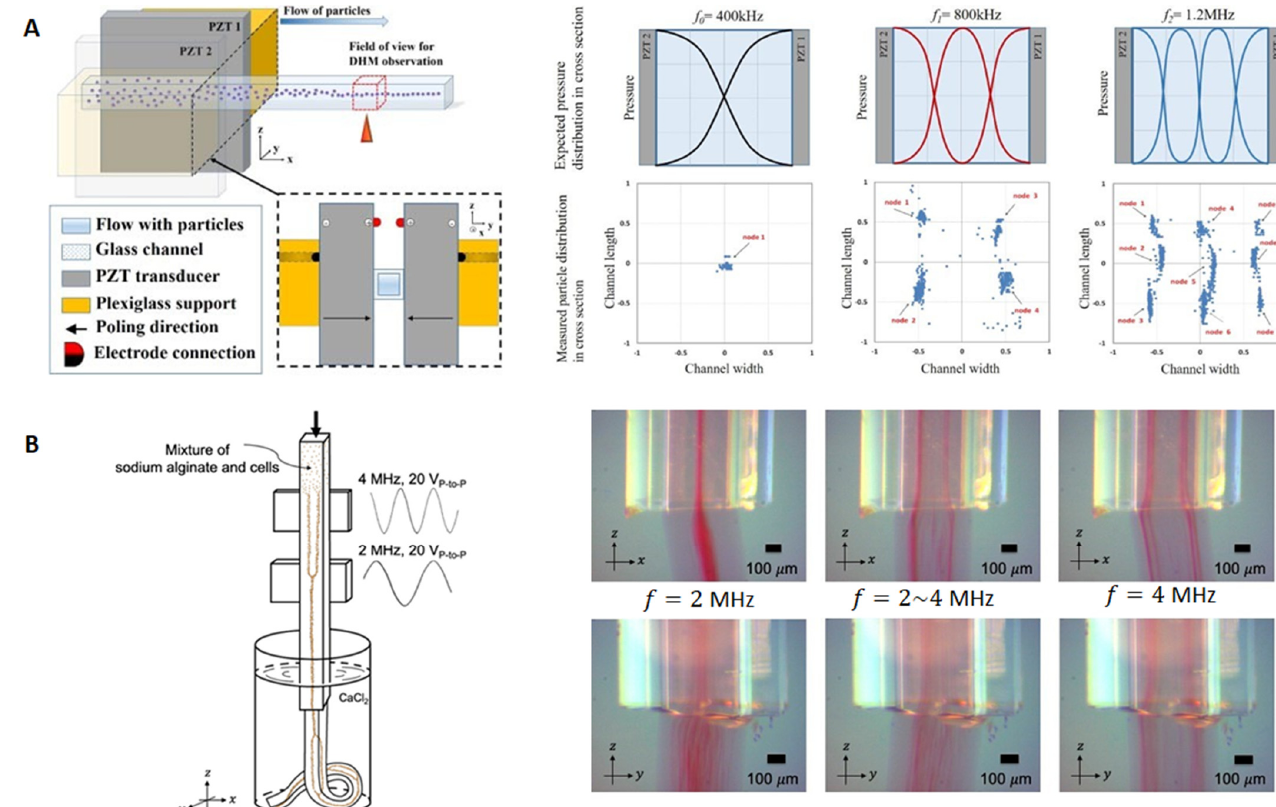
Figure 6. Acoustic alignment and patterning of microparticles in square cross-section glass capillaries using BAWs. ( A ) Particle alignment and patterning in a square glass capillary ( 𝑎 = 2 mm) by acoustic waves generated from two opposing PZTs. Reprinted with permission from [53] . ( B ) Acoustic particle and cell patterning in hydrogel in a square glass capillary ( 𝑎 = 0.4 mm) at cavity modes generated from a single PZT. Reprinted with permission from [54] .